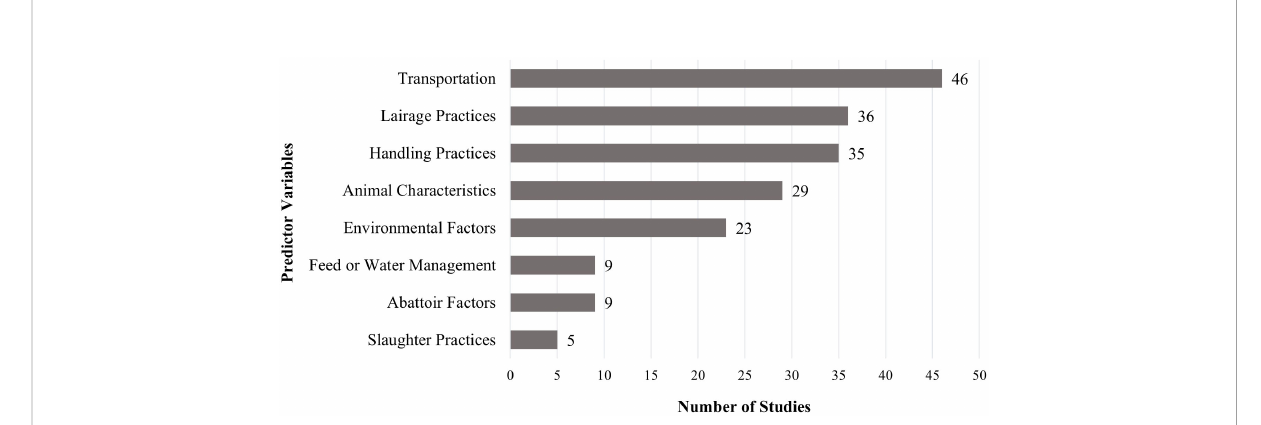
FIGURE 3 Number of studies that reported pre-slaughter management factors as predictors for meat quality outcomes ( n =85). Pre-slaughter management factors were categorized into eight broad categories, including slaughter practices, abattoir factors, feed or water management, environmental factors, animal characteristics, handling practices, lairage practices, and transportation. Some studies may have researched more than one pre- slaughter